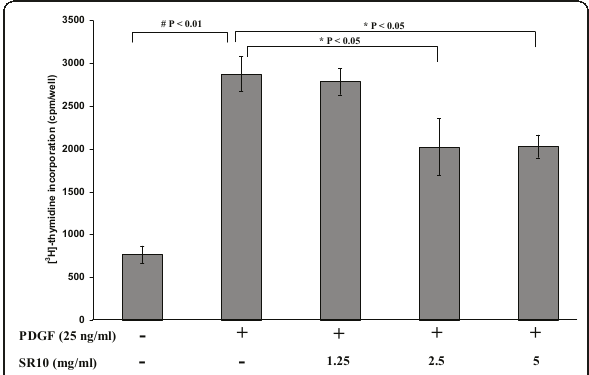
Figure 4 Effect of SR10 on PDGF-BB-induced 3 H-thymidine incorporation in A7r5 cells . Cells were treated with PDGF-BB (25 ng/ ml) for 24 hours in the absence or presence of SR10 and incorporation of 3 H-thymidine was measured. Data was expressed as mean ± S.D. with six replicates for each of three independent experiments. By Mann-Whitney test, significant difference when compared to PDGF-BB alone was indicated by *p < 0.05 or # p <